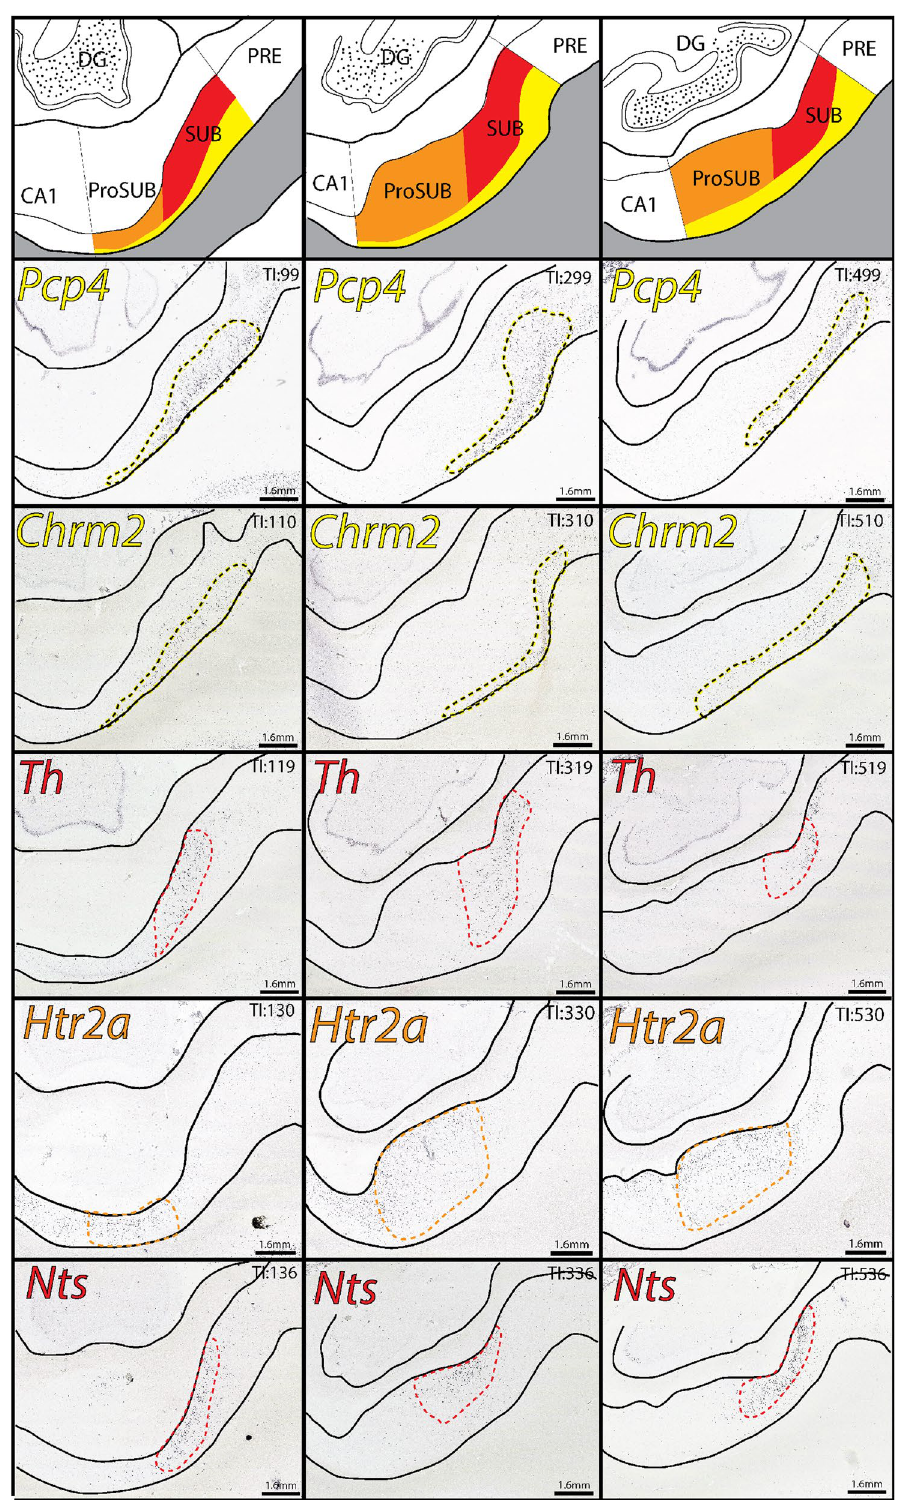
Figure 3. Gene expression domain boundaries shift across the longitudinal axis, but maintain their complementary relationship. In situ hybridization images of distribution patterns for Pcp4 , Chrm2 , Th , Htr2a , and Nts gene expression (outlined in yellow, red, or orange colors) at three different rostrocaudal levels spanning 8 mm of the longitudinal axis (posterior to anterior from left to right). Tissue Index (TI) numbers on each image reference section number in tissue series. Pcp4 and Th expression patterns closely mirror the distribution patterns of Chrm2 and Nts , respectively. On the top are corresponding atlas drawings demarcating each of the three laminar molecular domains (drawings based on the boundaries drawn in the Th -labeled sections). Note, at most posterior levels (TI: 99–136), the area of the ProSUB is small compared to the more anterior levels. All in situ hybridization images downloaded from www.brain